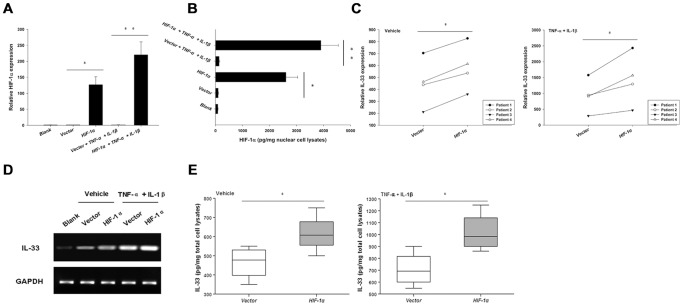
Enforced HIF-1α expression in RASF upregulated IL-33 levels.A, RASF were transfected with pcDNA3.1 or pcDNA3.1-HIF-1α for 24 h, then were stimulated with 10 ng/ml TNF-α plus 2 ng/ml IL-1β. The HIF-1α mRNA levels (A) as well as protein levels (B) were first assayed to confirm the overexpression. Cells were harvested 4 h after stimulation for realtime PCR (C) and RT-PCR (D) analyses of IL-33. 24 h later, cells were collected for measuring IL-33 protein levels (E) by cell lysate ELISA (Wilcoxon signed-rank test, *p<0.05, **p<0.001). The results were presented as mean±SEM of four independent experiments.